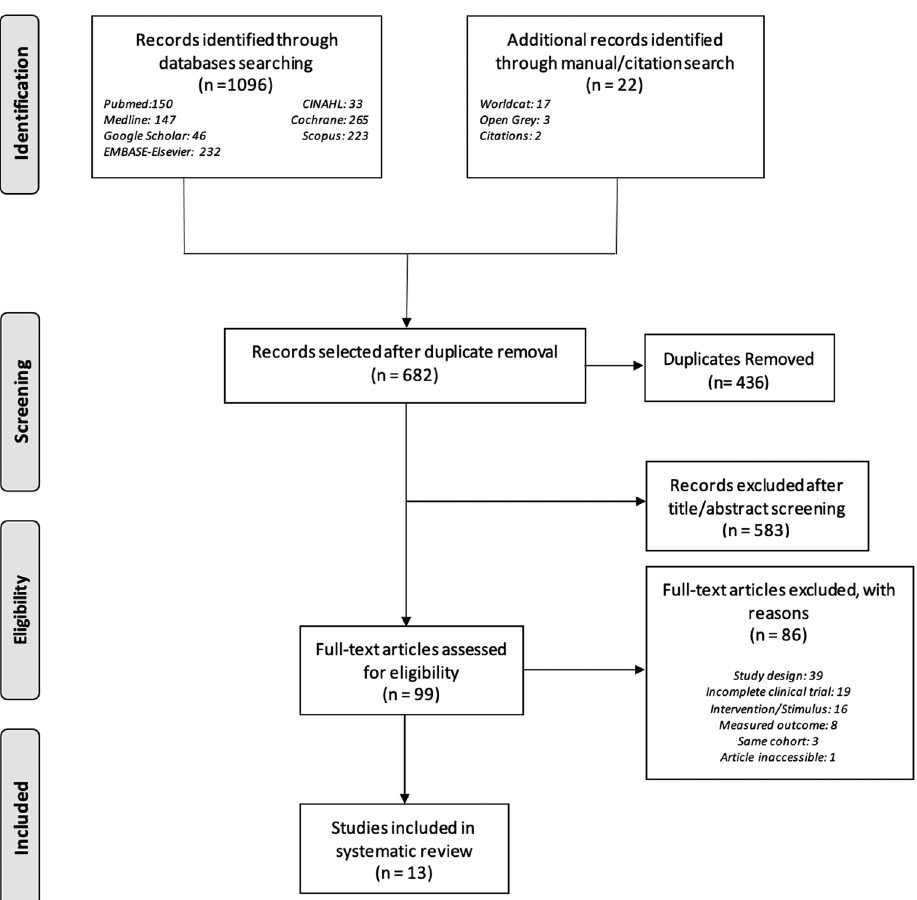
Figure 1. PRISMA flow diagram of article selection process. PRISMA: Preferred Reporting Items for Systematic Review and